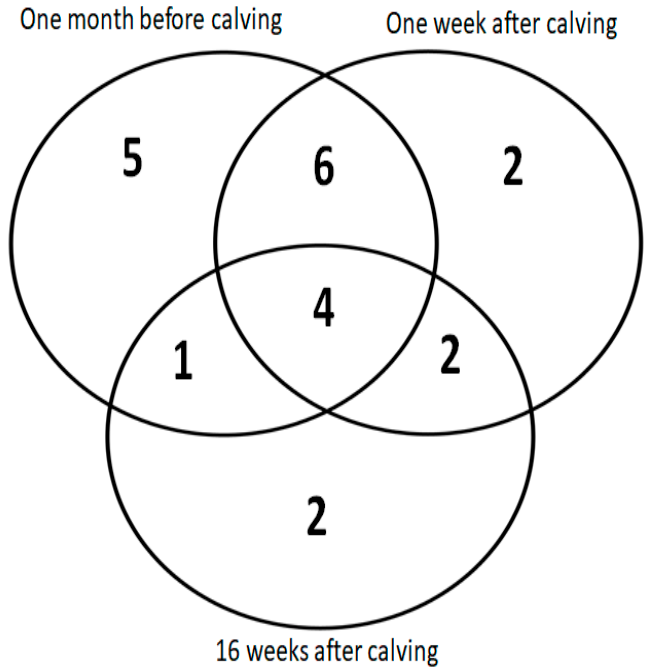
Figure 5. Venn diagram representing the distribution of di ff erentially expressed proteins. This Venn diagram represents the di ff erential expression of the data represented in Table 3 of the di ff erential protein expression of the sNEB group vs. lNEB group.